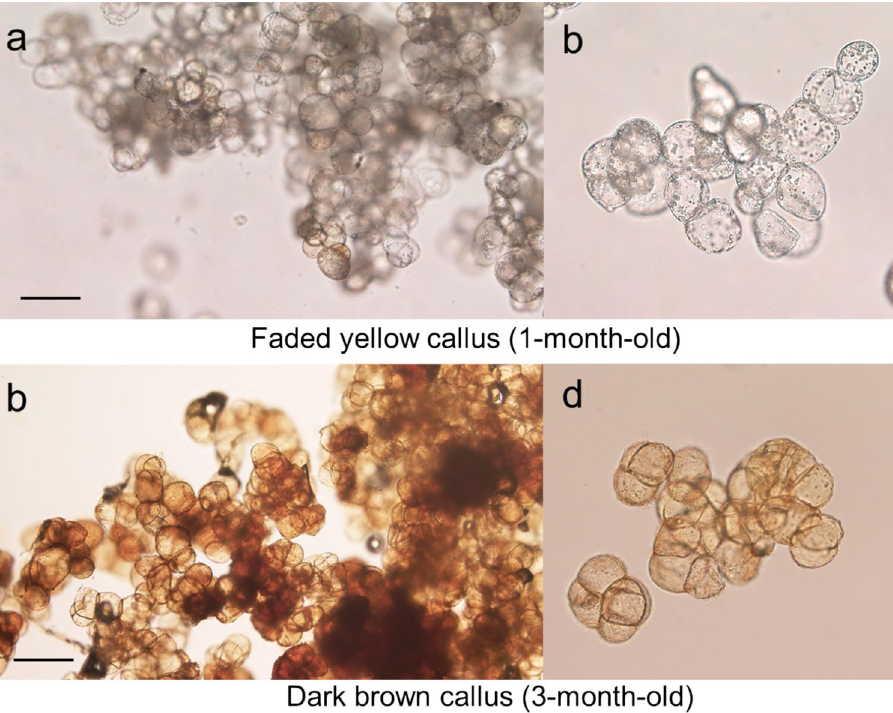
Figure 4. Light microscopic observation of yellow and dark brown calli. ( a ) Faded yellow callus after one month of culture constituted with cell mass with spherical cell structure with dense cytoplasm. ( b ) Callus constituted with cell mass with spherical cell structure with brown pigment. Right side of photos are enlarged views. Bars in ( a,b ) = 50